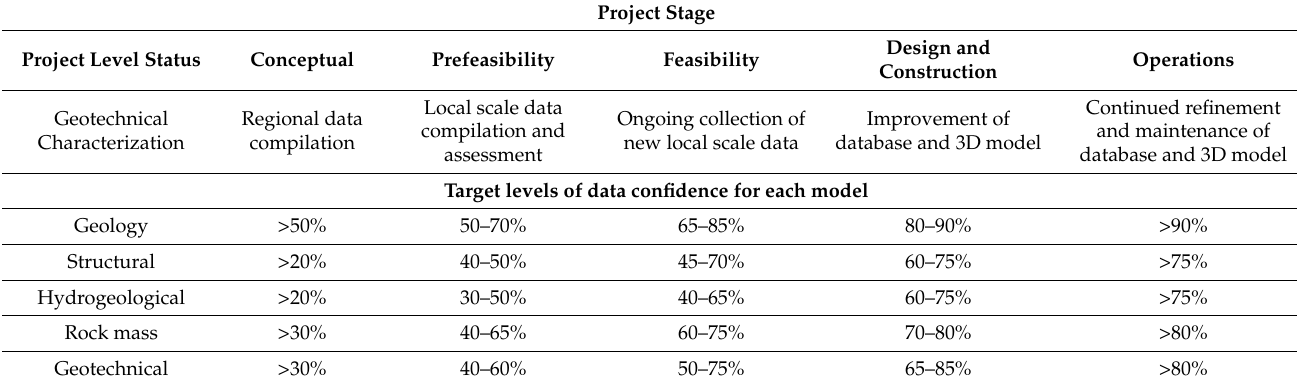
Table 1. Confidence level targets by project stage (data after